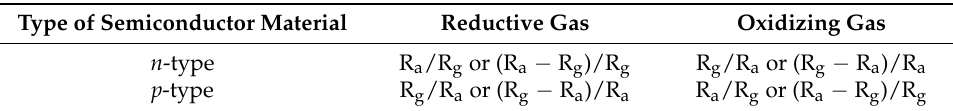
Table 2. Definition of sensor